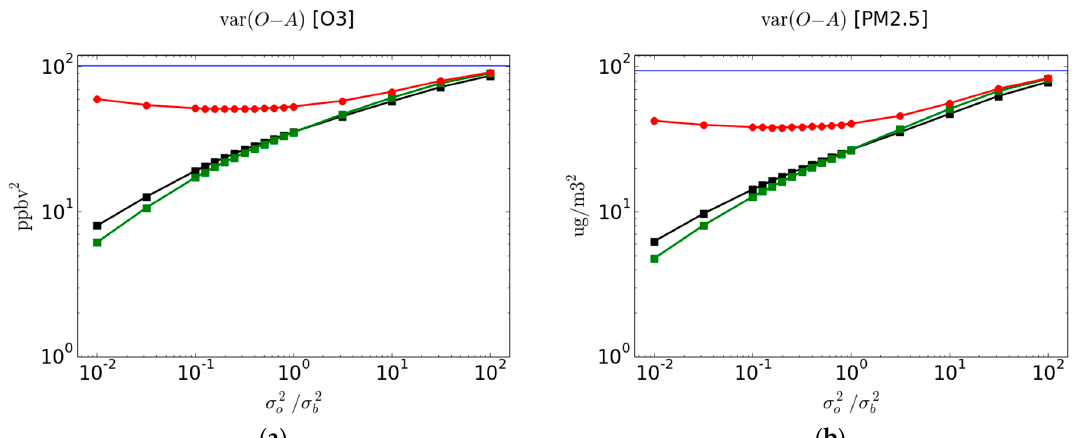
Figure 2. Variance of observation-minus-analysis residuals of O 3 and PM 2.5 for both active and cross-validation passive observations as a function of γ = σ 2 o / σ 2 . ( a ) is for O 3 with ordinates in ppbv 2 units, and ( b ) is for PM 2.5 with ordinates in ( µ g/m 3 ) . Red curve results from the evaluation at the passive observation sites (average of the 3-fold subsets). Black curve results from evaluation at the active observation sites with analyses using all observations. Green curve results from the evaluation at the active observation sites in the cross-validation experiment (i.e., using 2/3 of the observations; average of the three subsets). Blue curve is the variance of observation-minus-model.